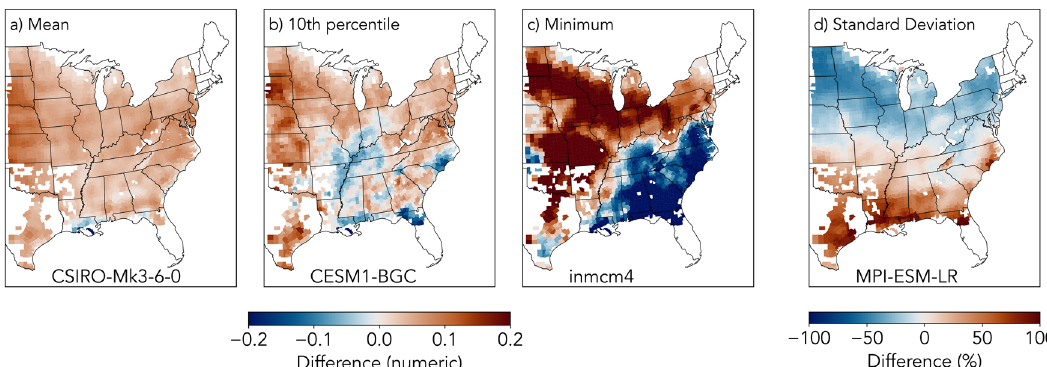
Fig. 2 County-level evaluation of NEX-GDDP maize yield hindcasts. County-level differences between the median-performing NEX-GDDP model and observational data for selected summary statistics from the historical distribution of maize log-yields. For each summary statistic, the median-performing model (reported at the bottom of each panel) is selected after taking an unweighted average over all counties east of the 100th meridian west and comparing to the equivalent observational data. Numeric differences are reported in panels a – c because for some counties the observational value is very close to zero, which arti fi cially in fl ates the percentage difference. For the standard deviation (panel d), we report percentage